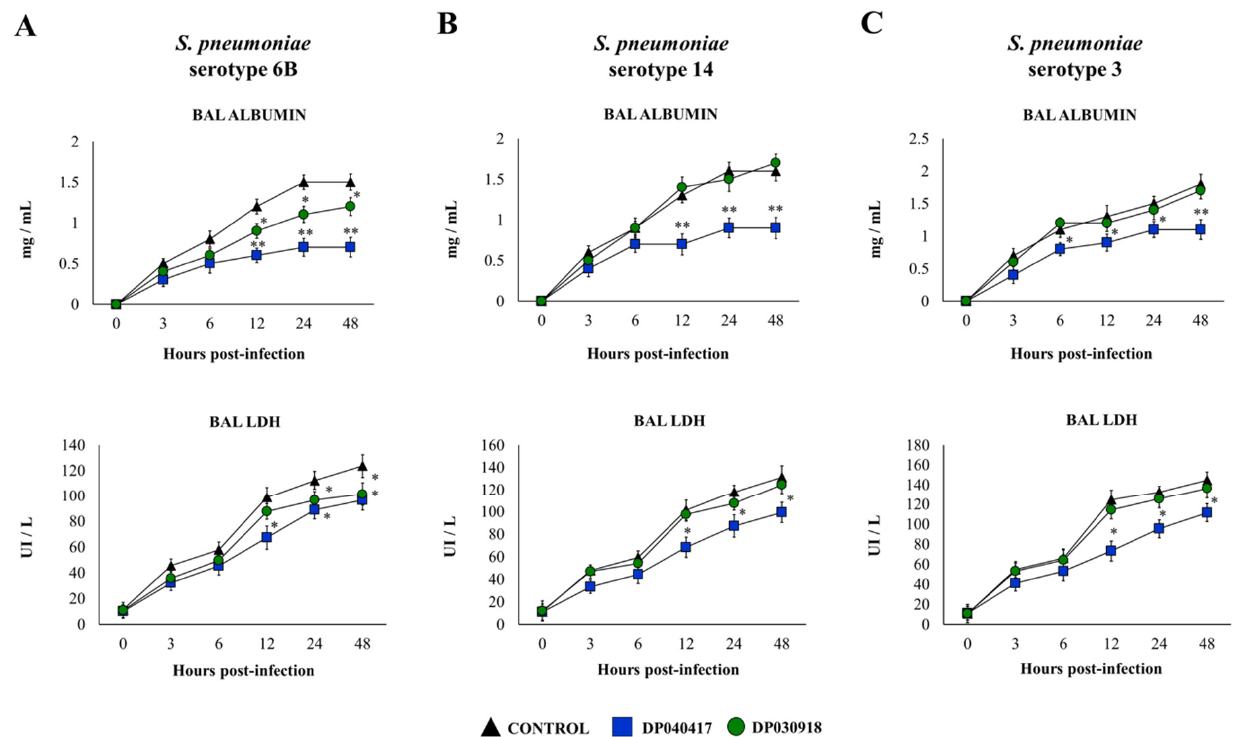
Figure 2. Effect of the respiratory commensal bacteria Dolosigranulum pigrum on resistance to Streptococcus pneumoniae infection. Infant mice were nasally primed with viable D. pigrum (DP) strain 040417 or 030918 during five consecutive days at a dose of 10 8 bacterial cells/mouse/day. One day after the last administration of DP strains, mice were challenged with ( A ) S. pneumoniae serotypes 6B ( A ), 14 ( B ), or 3 ( C ). Non-treated infant mice challenged with the corresponding serotypes of S. pneumoniae were used as controls. Lactate dehydrogenase (LDH) activity and albumin concentrations in broncho-alveolar lavages (BAL) were evaluated on different time points after the bacterial challenge. The results represent data from three independent experiments ( n = 6 per each group at each time point). Significantly different when compared with control at the same time point, * p < 0.05 or ** p < 0.01.